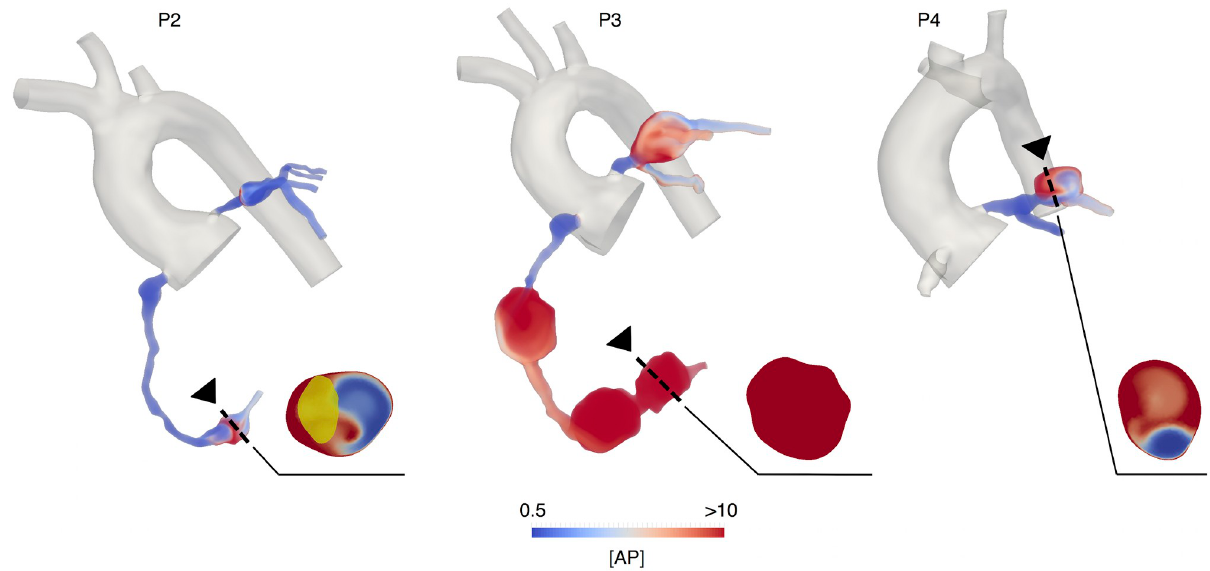
Fig 4. Qualitative comparison of [ AP ] spatial distribution for Kawasakidisease patients classified as high thrombotic risk. Arrow indicates region of confirmed thrombosis. Yellow shaded area represents the thrombus segmentation from image data. [ AP ] = Activated platelet concentration.